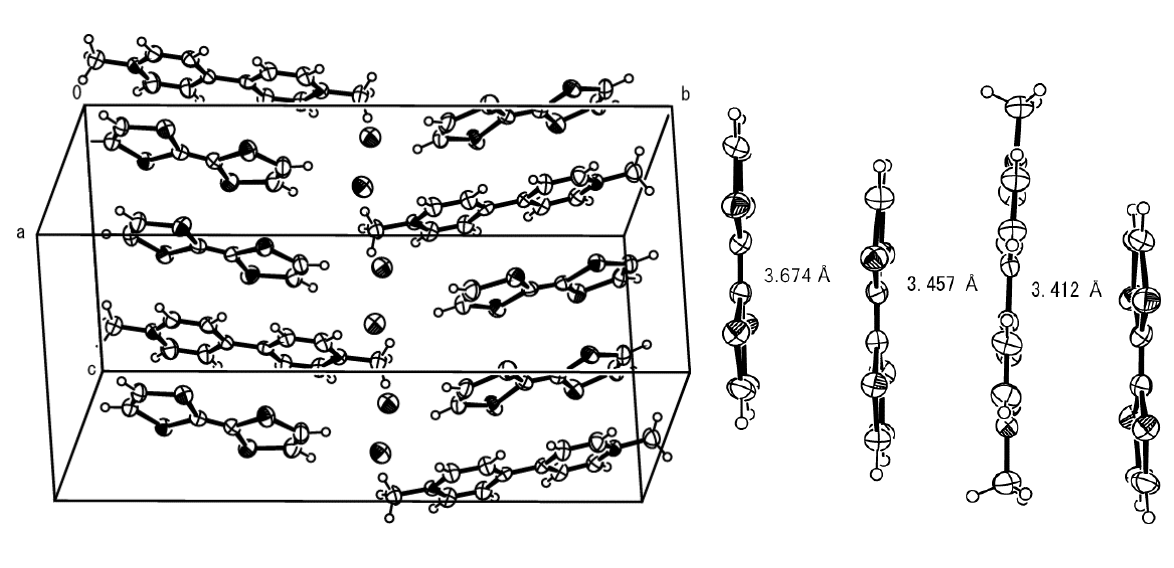
Figure 1. Left: crystal structure of complex 4 . Water molecules are removed for clarity. Right: side view of DDA and D arrangement with indication of interplanar